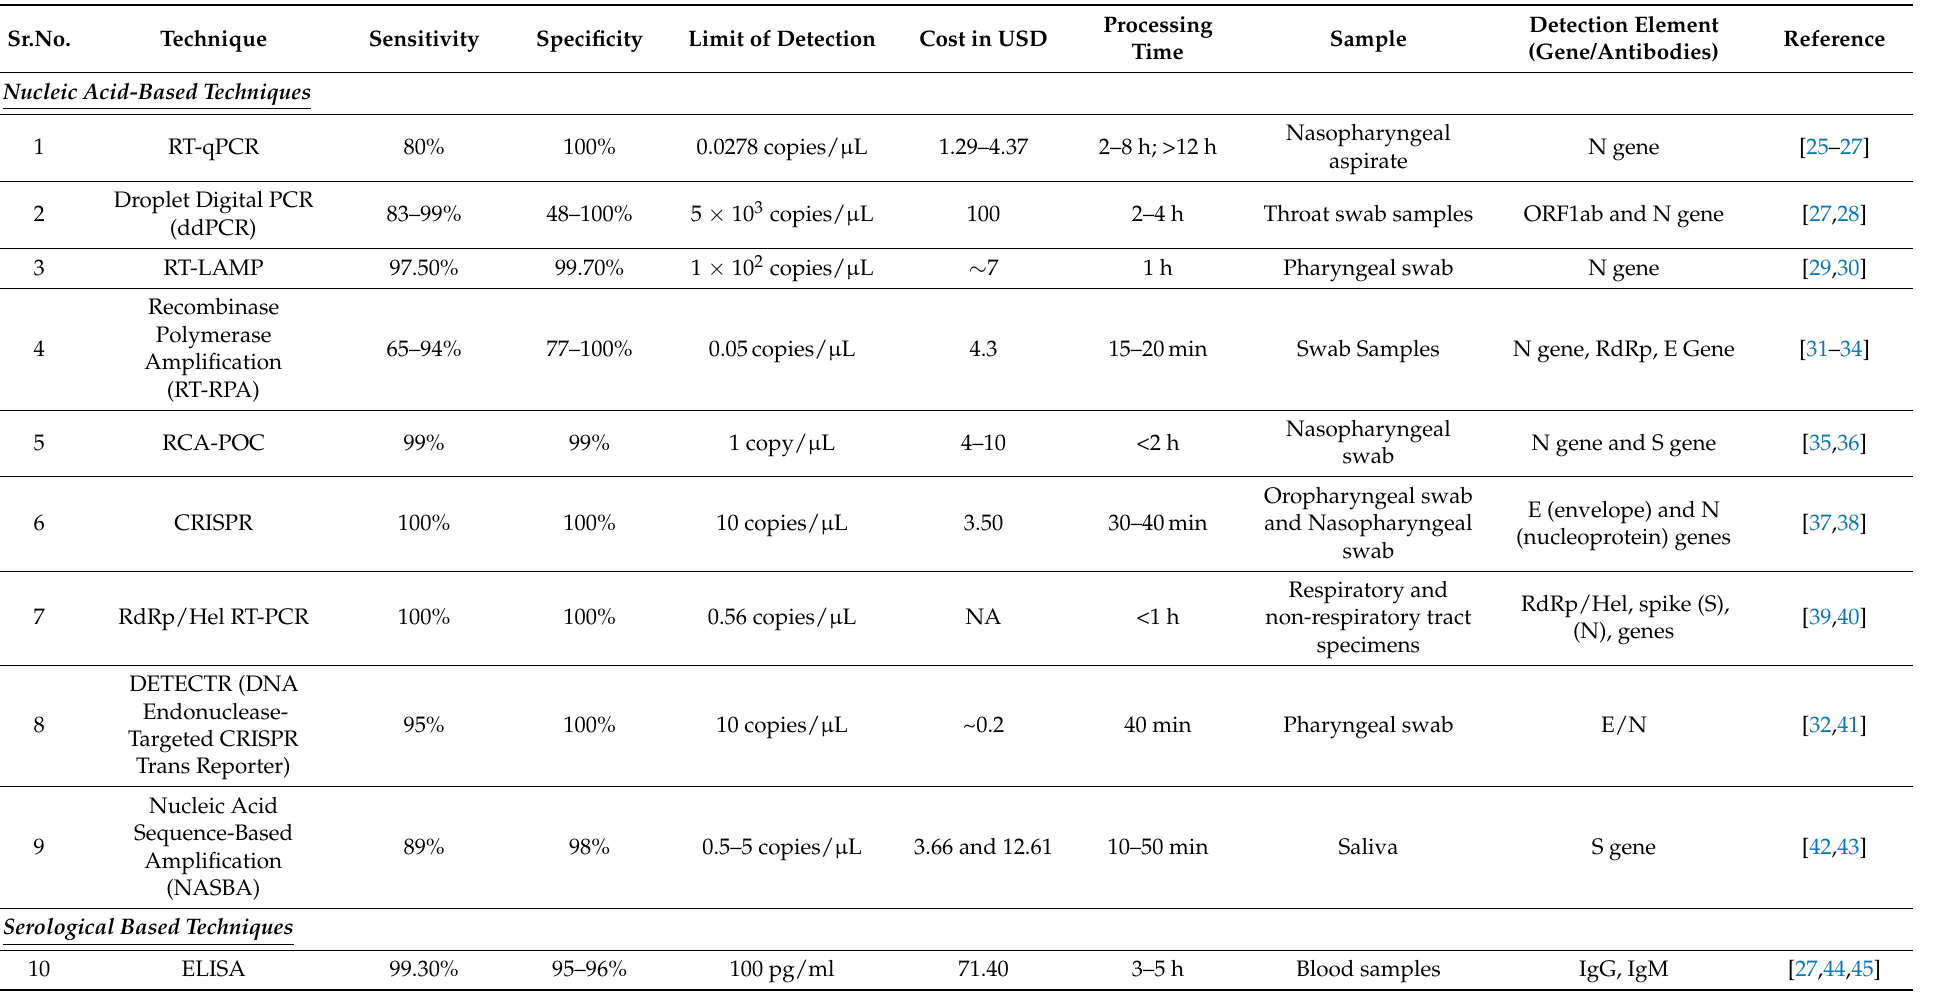
Table 1. Different diagnostic techniques currently being used for severe acute respiratory syndrome coronavirus 2 (SARS-CoV-2).